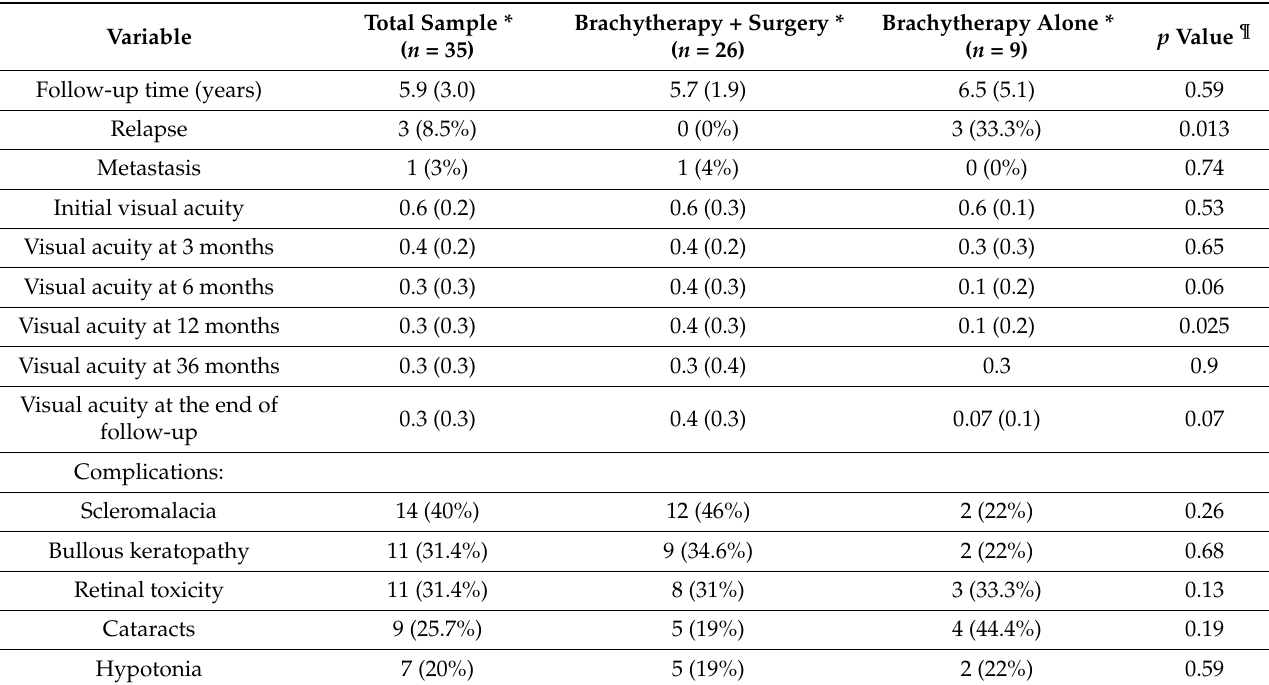
Table 3. Clinical outcomes and complications during follow-up according to the initial